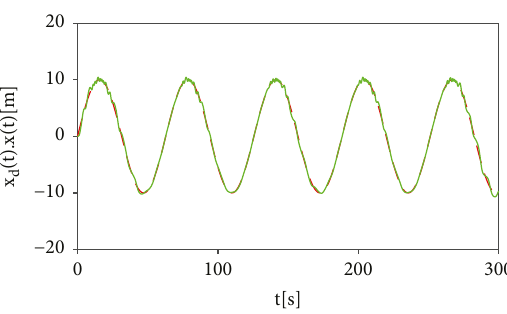
Figure 4: Total energy of the system.